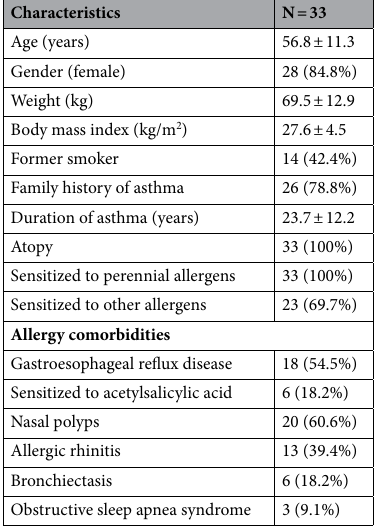
Table 1. Summary of demographic and baseline clinical characteristics of the enrolled cohort (continuous data are presented as mean ± standard deviation, categorical data as absolute number and percentage in brackets).